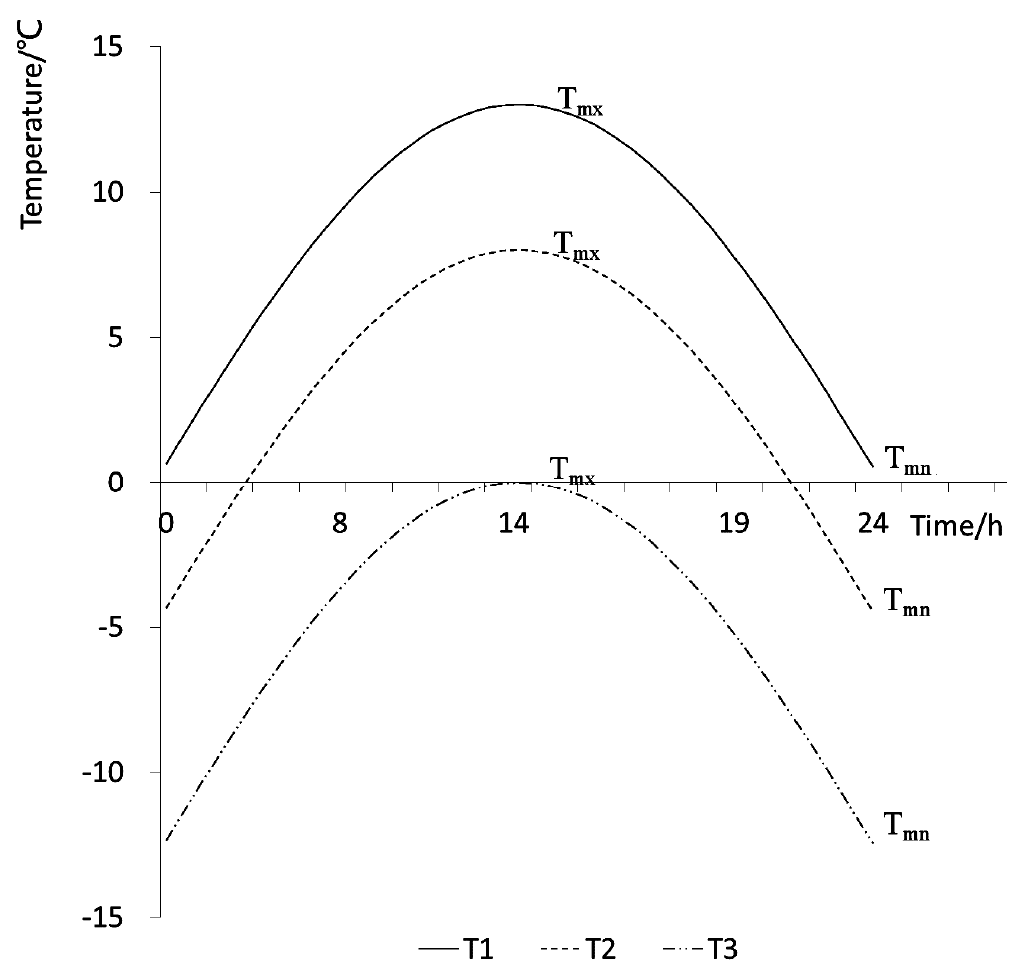
Figure 4. Three different daily temperature variations Figure 4. Three di ff erent daily temperature